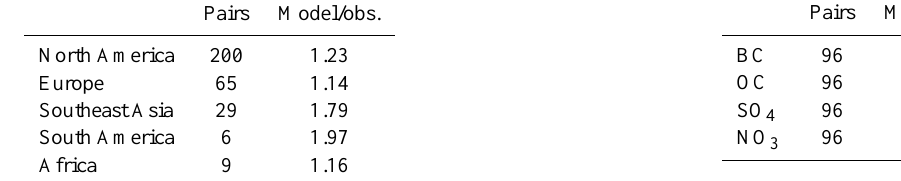
Table 5. Mean ratio between the simulated and observed aerosol Table 4. Mean ratio between the simulated and observed BC mass mass concentrations of the data presented in Fig. 4 and number of concentrations (model/obs.) shown in Fig. 3 and number of data stations considered for the comparison (pairs). points in each panel of Fig. 3 (pairs). Pairs Pairs Model/obs. North America